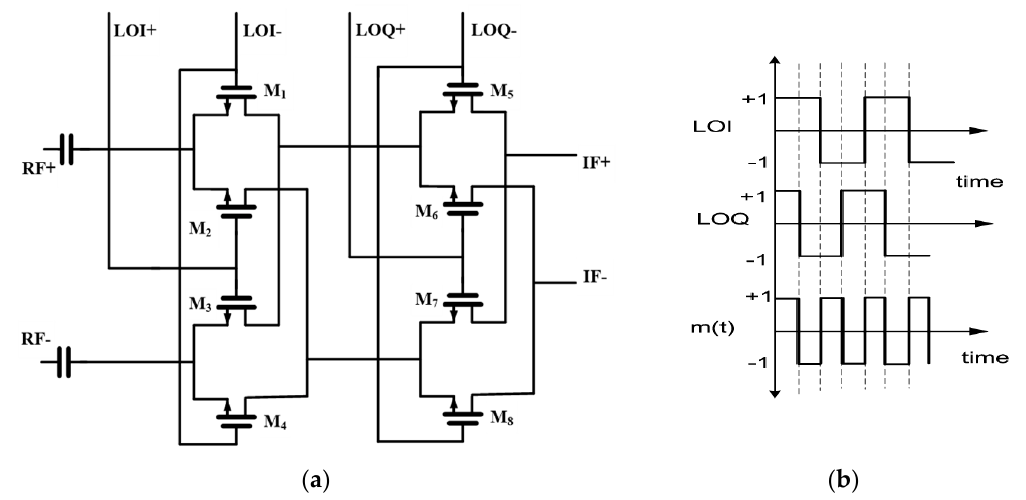
Figure 6. ( a ) Mixer core; and ( b ) its mixing function. RF, radio frequency.